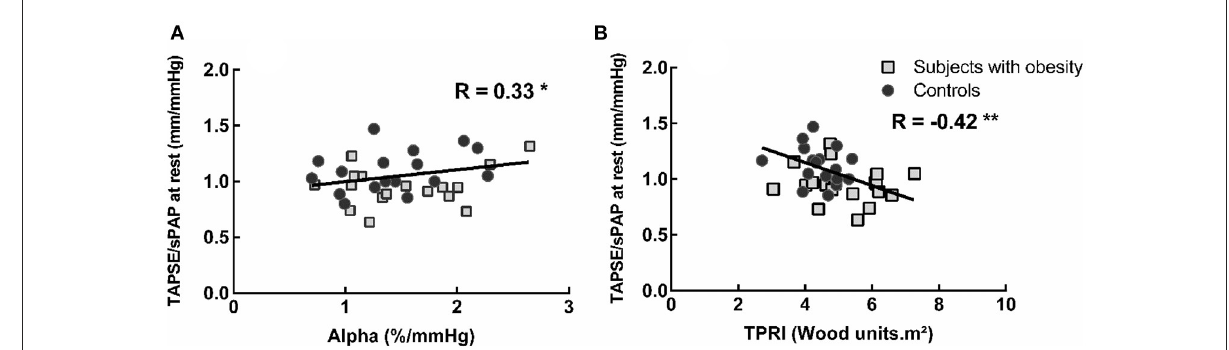
FIGURE3 Correlation between the TAPSE/sPAP ratio at rest and the pulmonary vascular distensibility coefficient alpha-total during exercise (A) and exercise indexed total pulmonary vascular resistance (TPRi) at normalized maximal common QI (B) . Subjects with lower pulmonary vascular distensibility and higher TPRi present lower TAPSE/sPAP ratios. * P < 0.05 and ** P < 0.01.